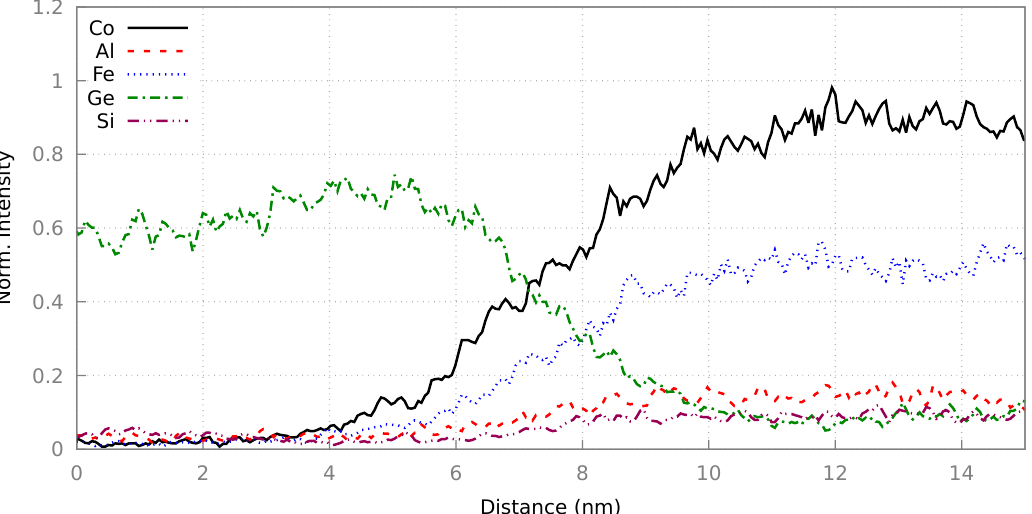
Figure 8. Energy dispersive X-ray spectroscopy (EDS) results across the as-grown CFAS/ n -Ge interface, showing significant mixing of the atomic species. Data taken from Kuerbanjian et al.